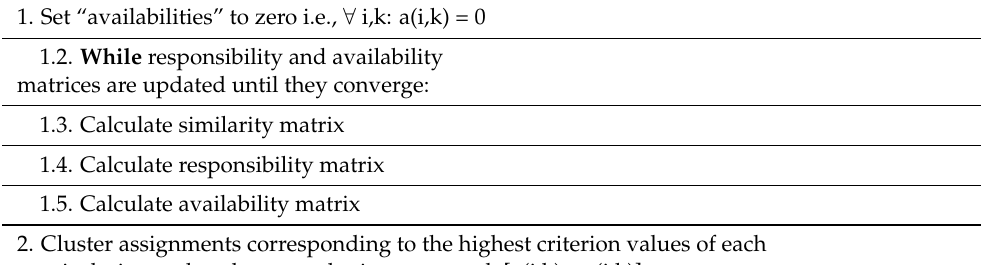
Table 10. Basic Affinity propagation